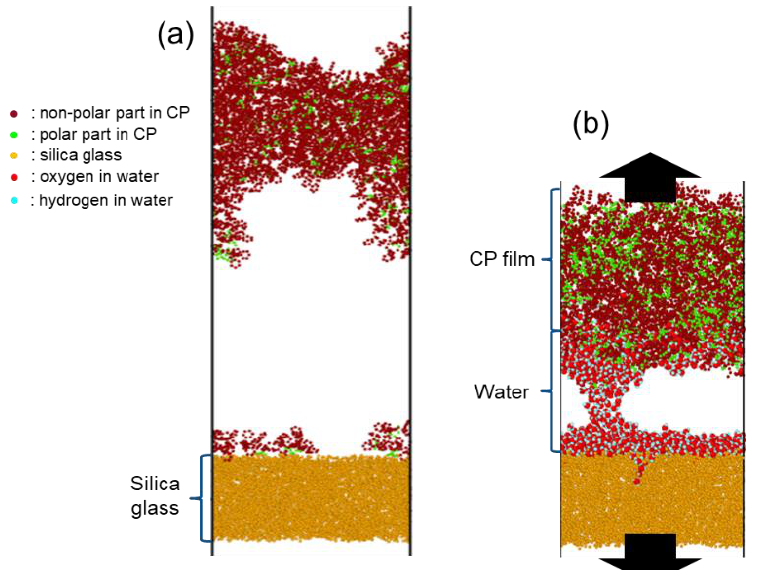
Figure 13. ( a ) Cohesive failure of copolymer (CP)–silica interface in the absence of water. ( b ) Adhesive failure of the interface in the presence of water during pulling test.